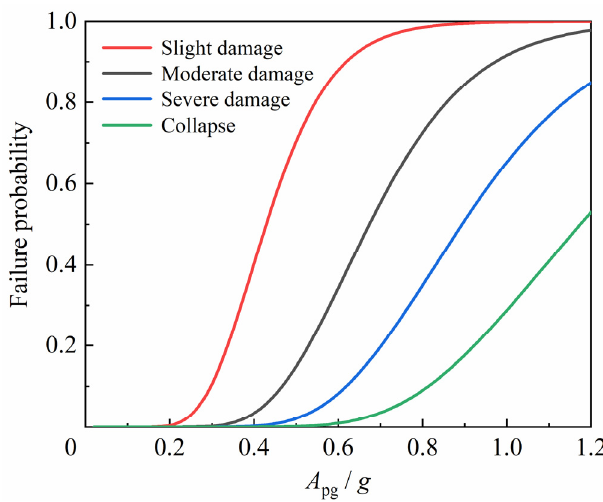
Figure 14. Vulnerability curves.